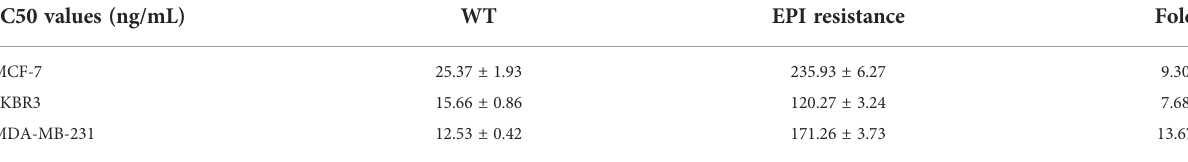
TABLE 1 EPI IC50 values in breast cancer cell lines and their chemoresistant variants (n = 3).